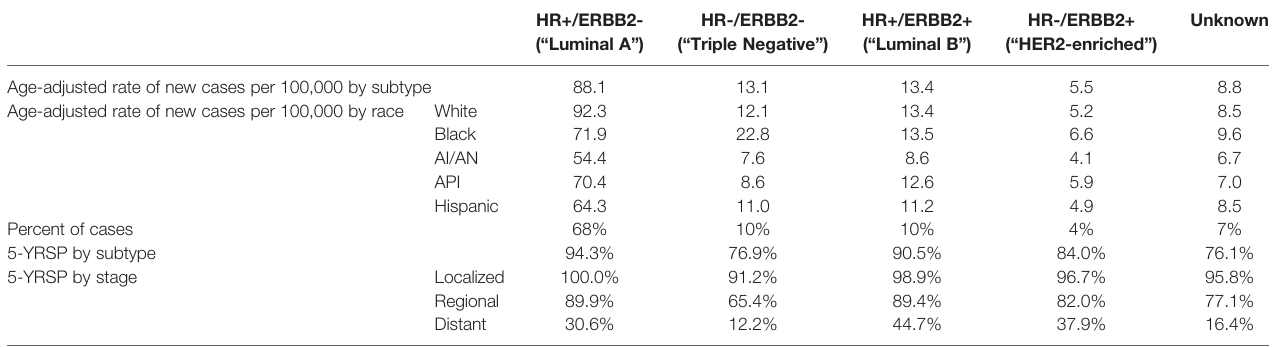
TABLE 2 | Statistics based on 2014 – 2018 cases according to the National Institutes of Health